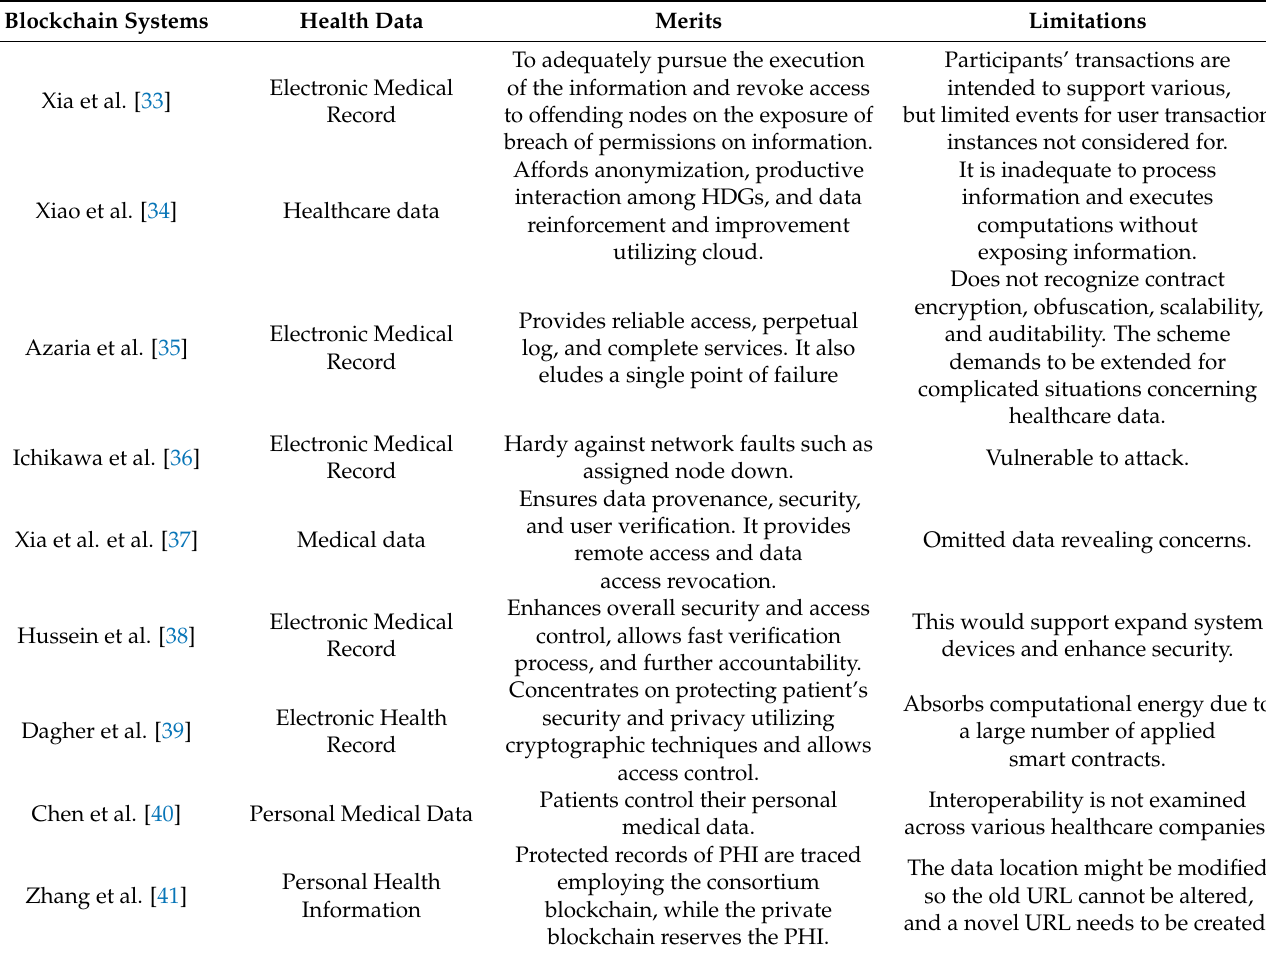
Table 1. Existing blockchain healthcare